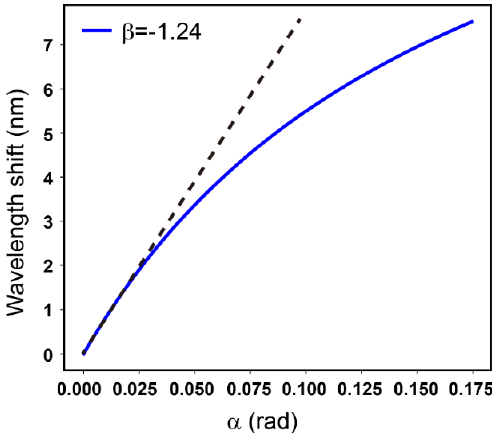
Figure 2. The theoretical response curve of wavelength shift with respect to α . The dotted line reveals the linear range for α detection.